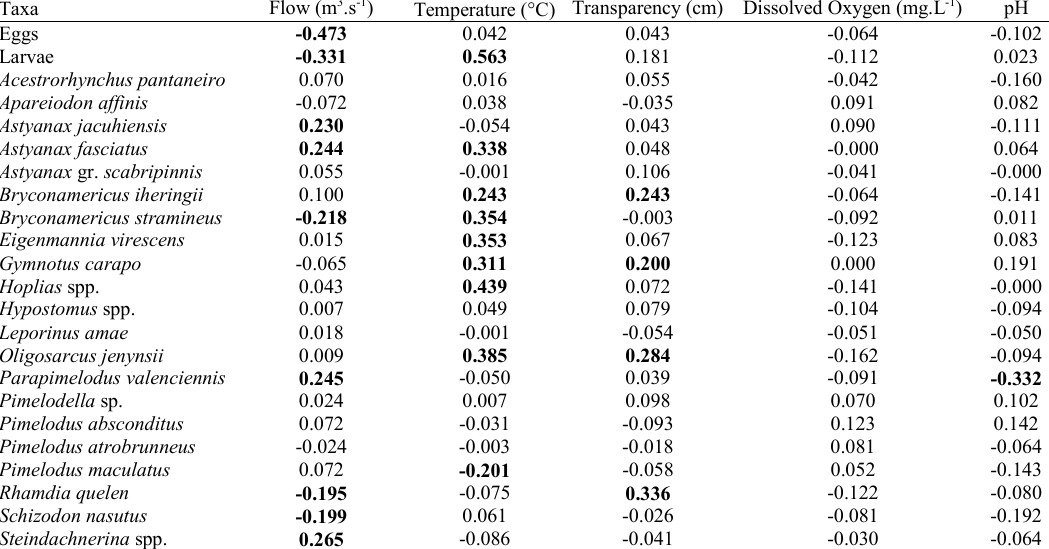
Table 4 . Pearson correlation among the environmental variables and eggs, larvae and the most abundant taxa (density log +1) in the upper Uruguay River from October 2001 to March 2004. Numbers in bold represent p <